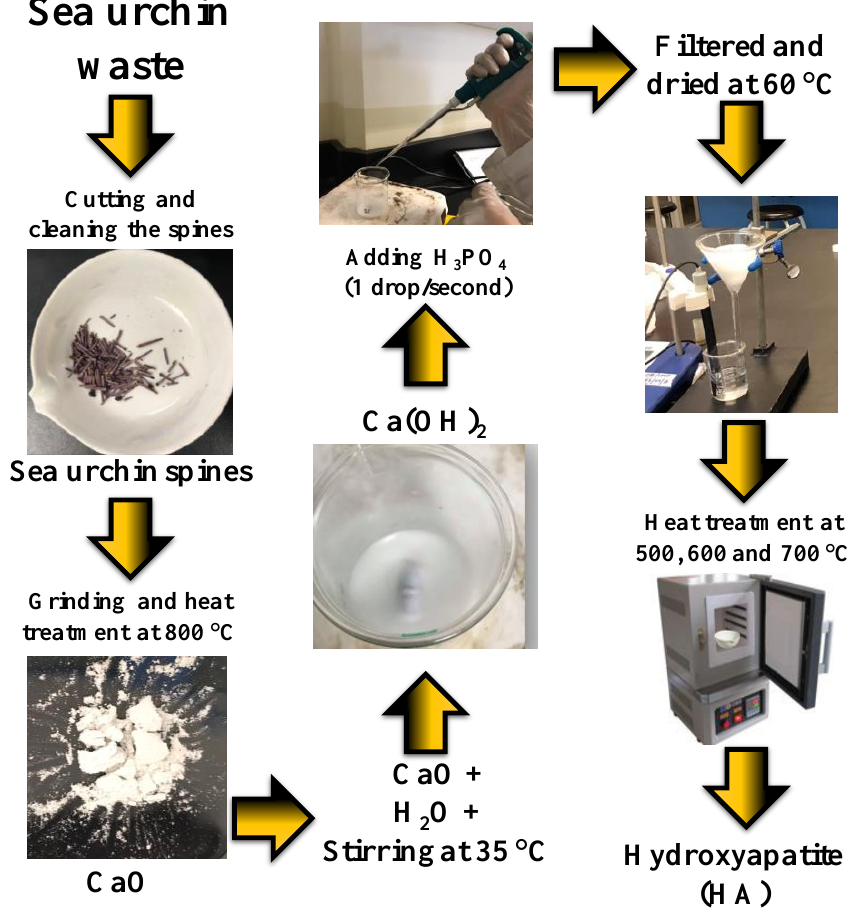
Figure 1. Biosynthesized hydroxyapatite (HA) from sea urchin spines.